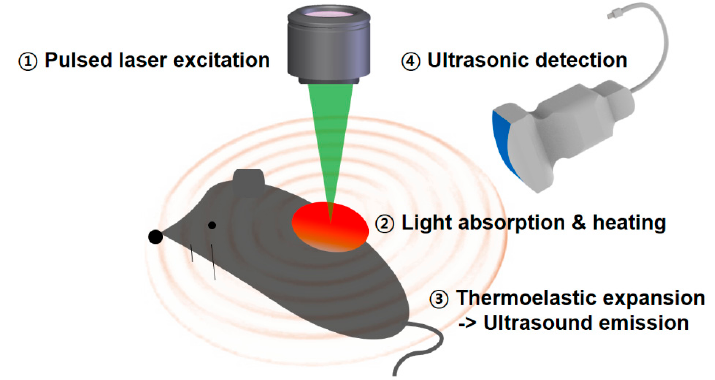
Figure 1. Schematic description of the generation of a photoacoustic signal.